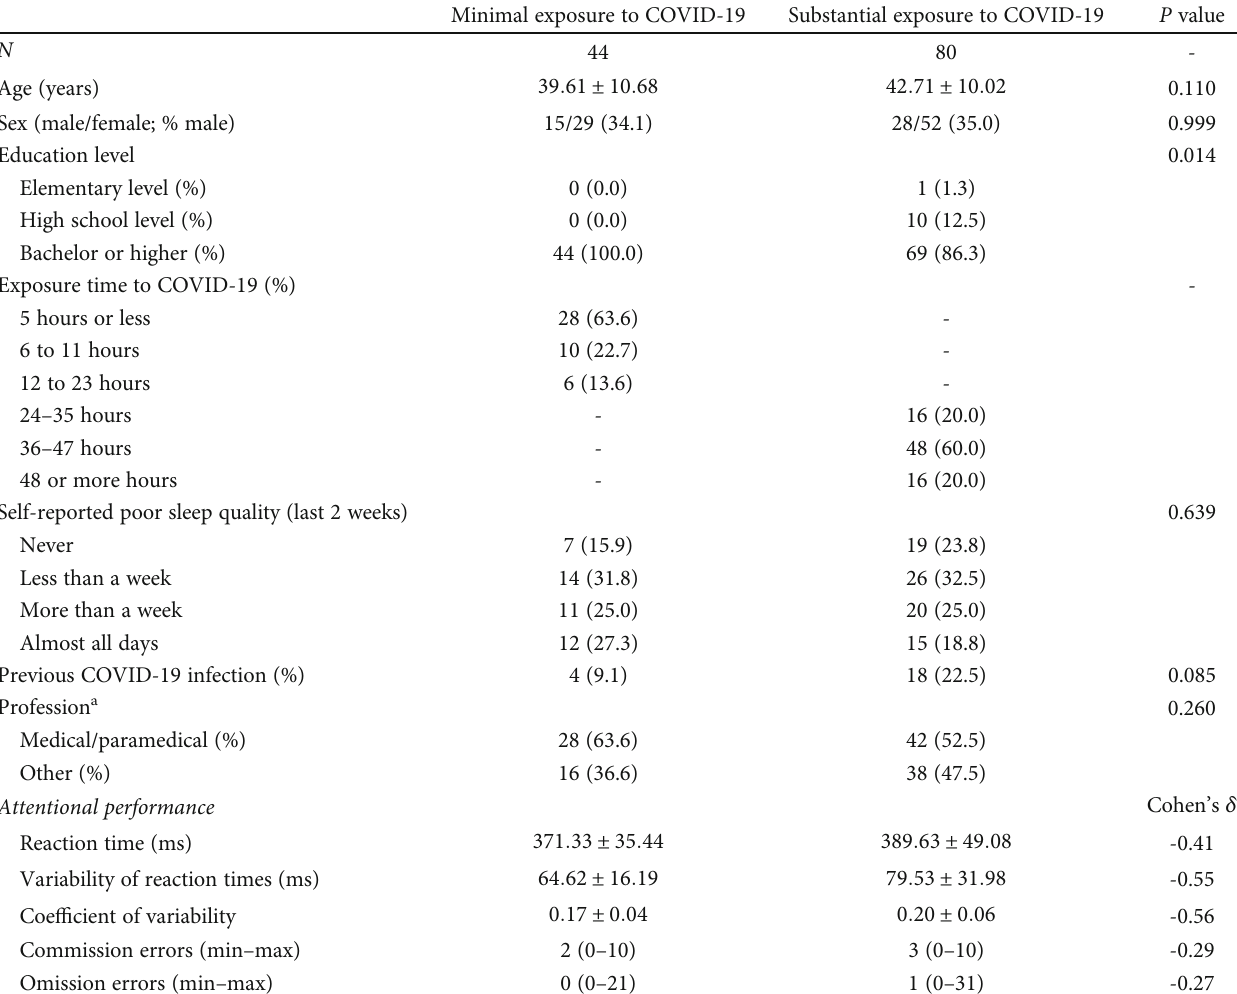
Table 1: Group characteristics of all included participants.